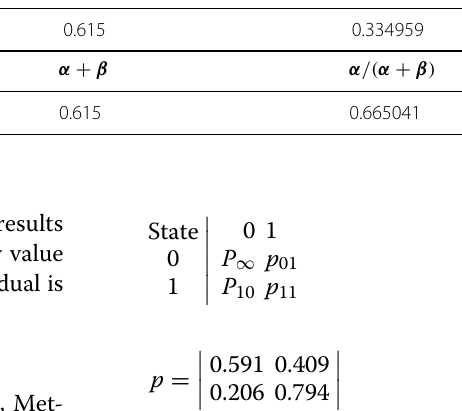
Table 5 Decrease and increase instant in all-share indexes. Source: Authors computation with data generated from NSE α